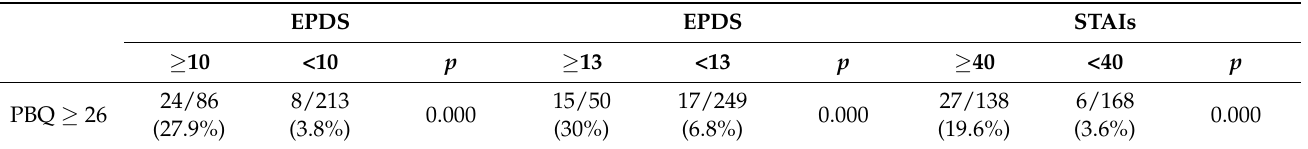
Table 5. Mother-to-infant bonding (PBQ) in relation to depression and anxiety symptoms (EPDS and STAIs) at different cut-off